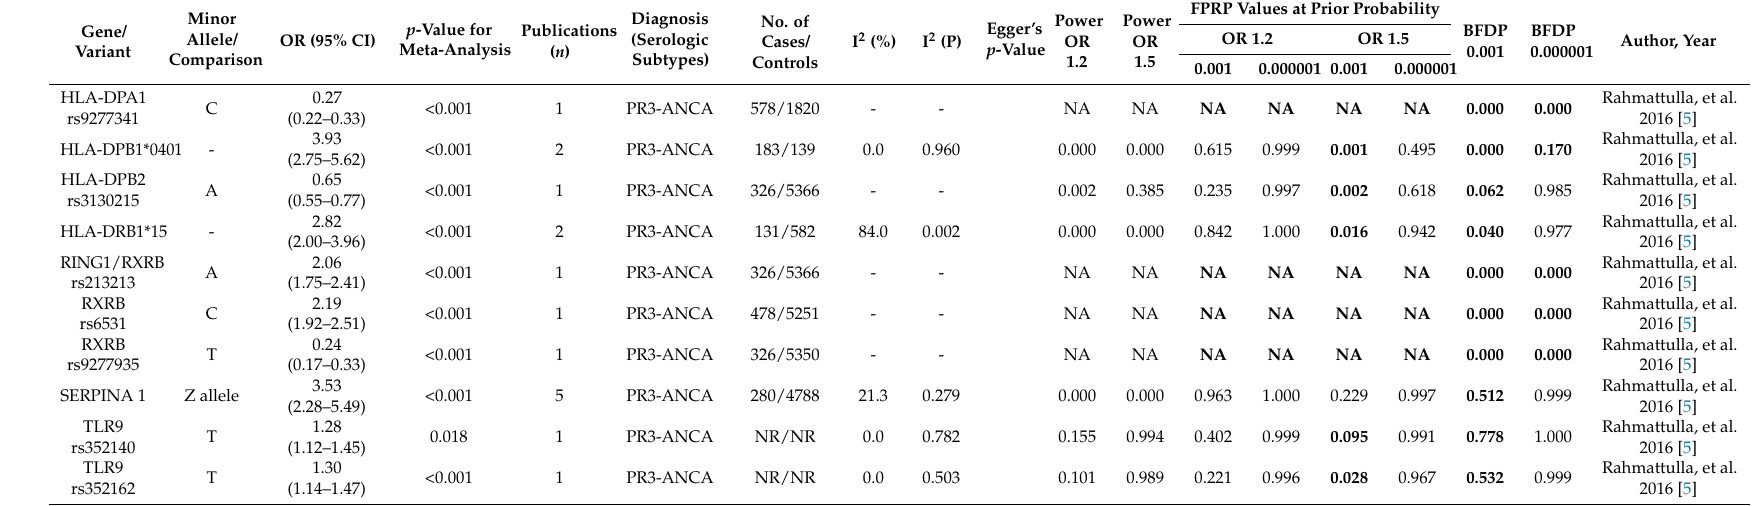
Table 2. Meta-analysis results of observational studies; gene variants with statistical significance ( p -value < 0.05), found to be noteworthy by FPRP or BFDP for each serologic diagnosis (MPO-ANCA and